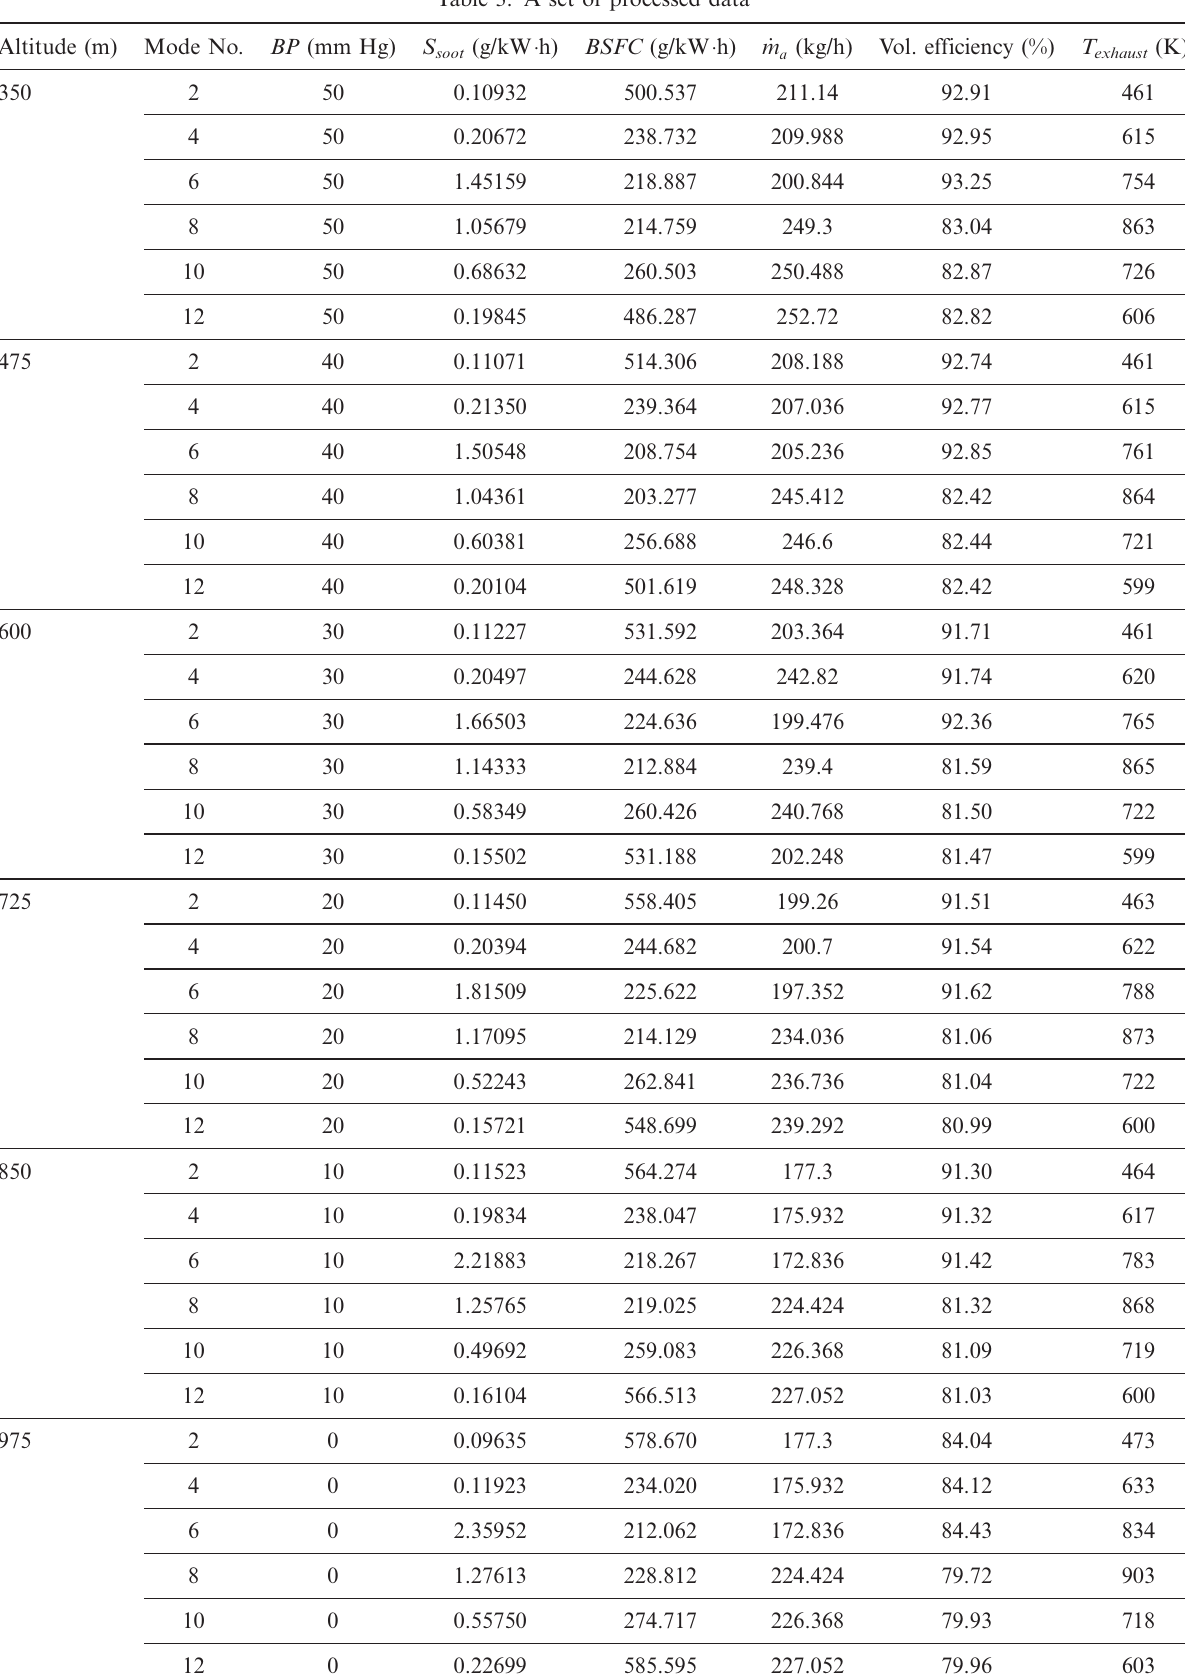
Table 3. A set of processed